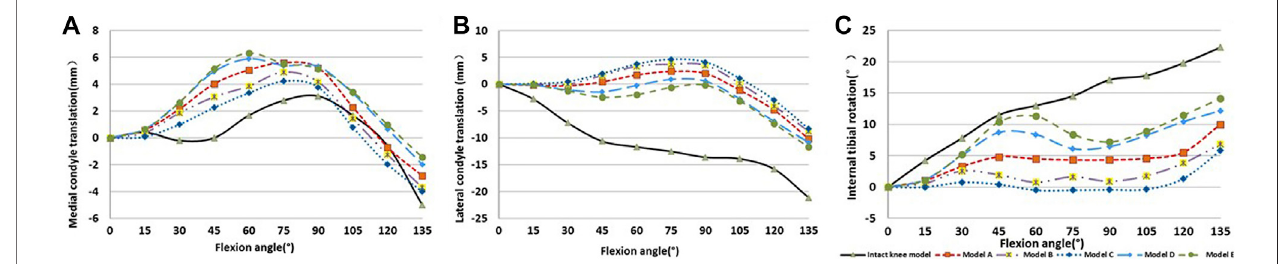
FIGURE 3 | The kinematics of TKA models and intact knee model. (A) Medial condyle translation, (B) lateral condyle translation, and (C) internal tibial rotation. Positive means anterior translation or tibia internal rotation against the femur. Negative indicates the opposite.